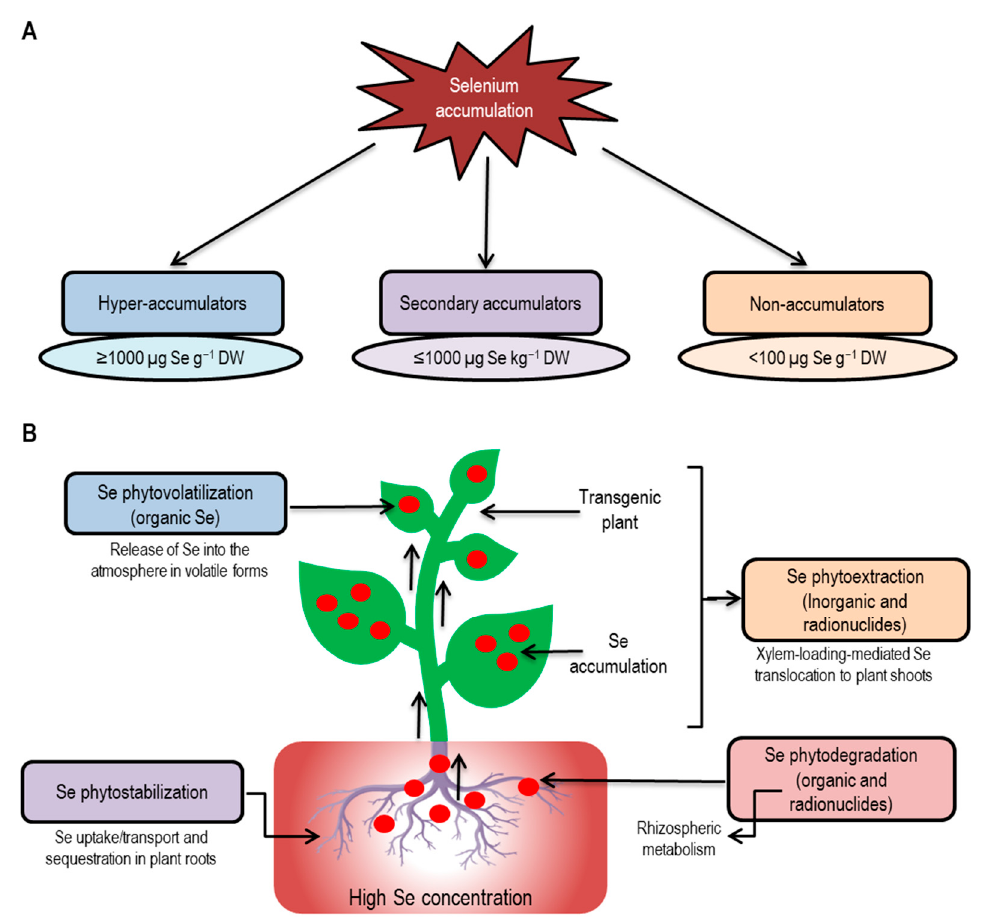
Figure 6. Phytoremediation of Se-polluted environments. ( A ) plants types according to Se accumulation in biomass), ( B ) phytoremediation processes of Se polluted environments. Various phytotechnologies can be used to remediate Se contaminants by accumulating them at large amounts